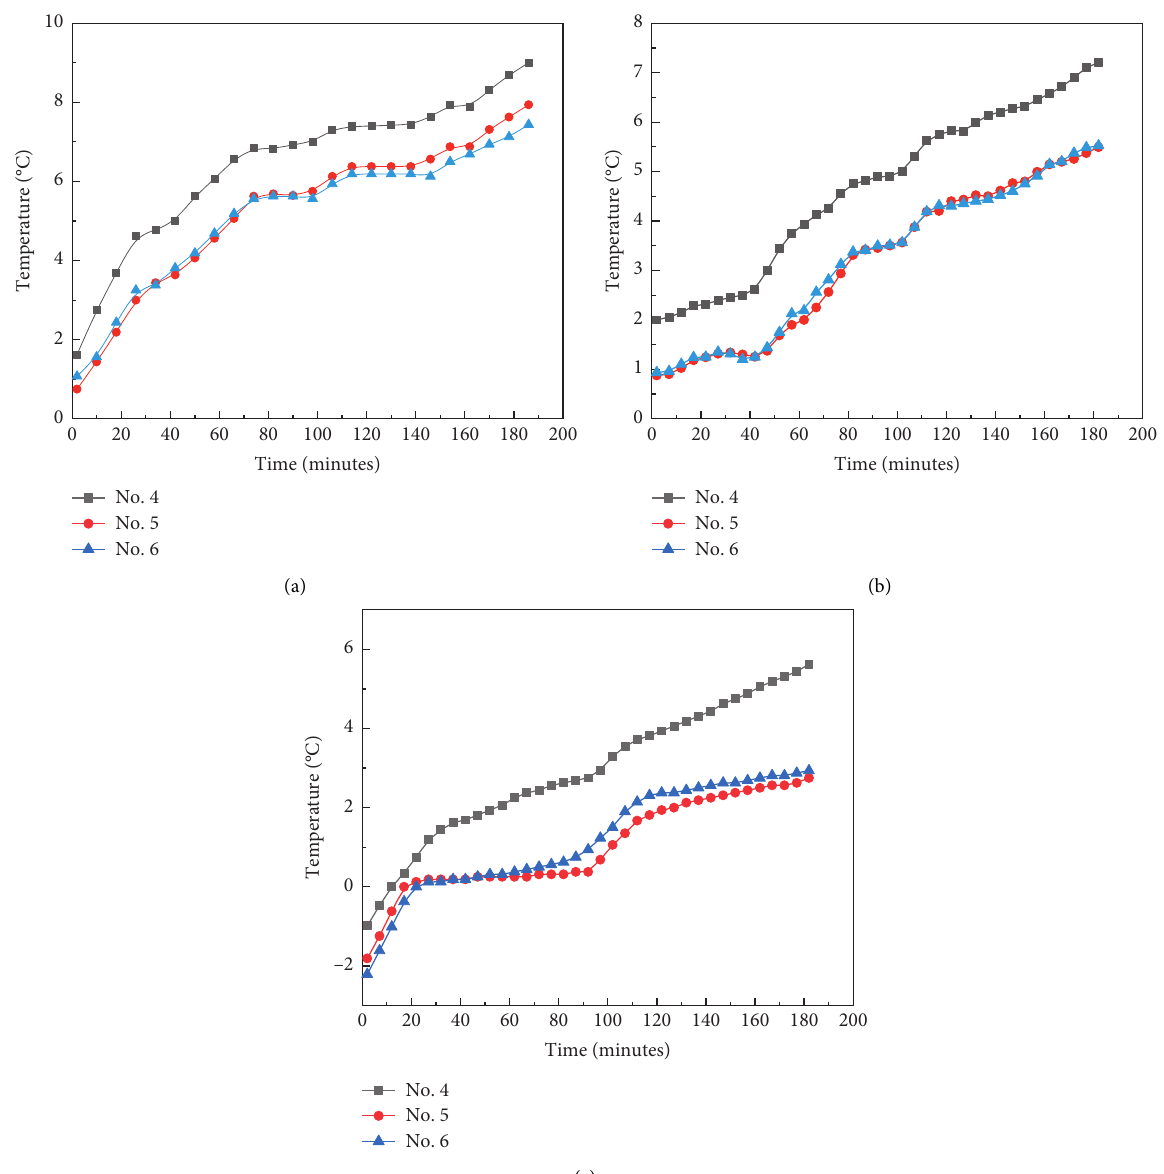
Figure 9: Temperature change curves of measuring points Nos. 4, 5, and 6 under various working conditions of temperature rise ex- periment: (a) − 2 ° C; (b) − 4 ° C; (c) − 8 ° C.